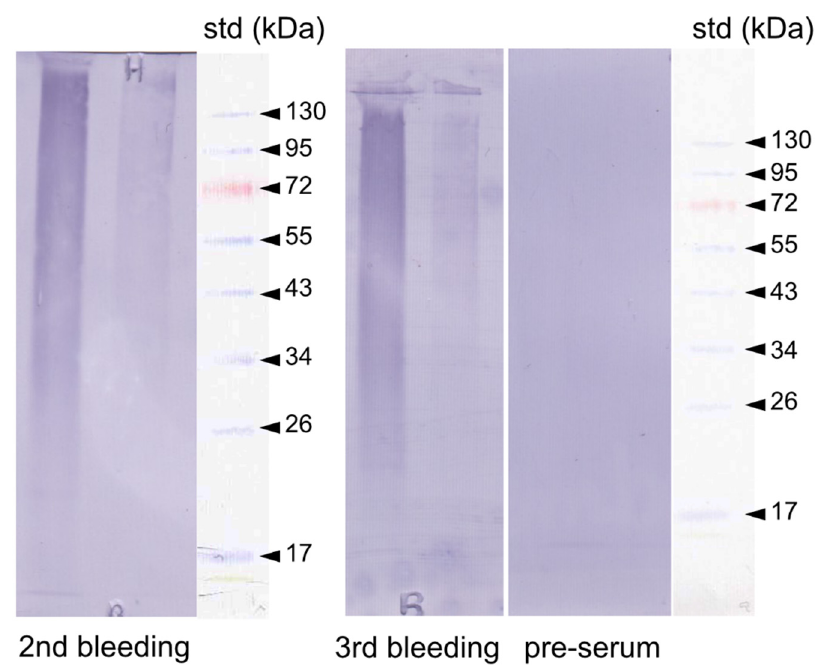
Figure 9. Western-blot of the ASM1 and laemmli soluble-acid insoluble matrix (LS-AIM1) extracts of the shell of Argonauta hians . The blotted extracts were incubated with a polyclonal antibody preparation (2nd and 3rd bleeding) elicited against a protein fraction, P95, identified in the soluble shell matrix of the freshwater mussel, Unio pictorum . The membrane was stained with BCIP / NBT (5-bromo-4-chloro-3-indolyl-phosphate / nitro blue tetrazolium). The pre-immune serum was used as negative control. Right sides: molecular weight standards.